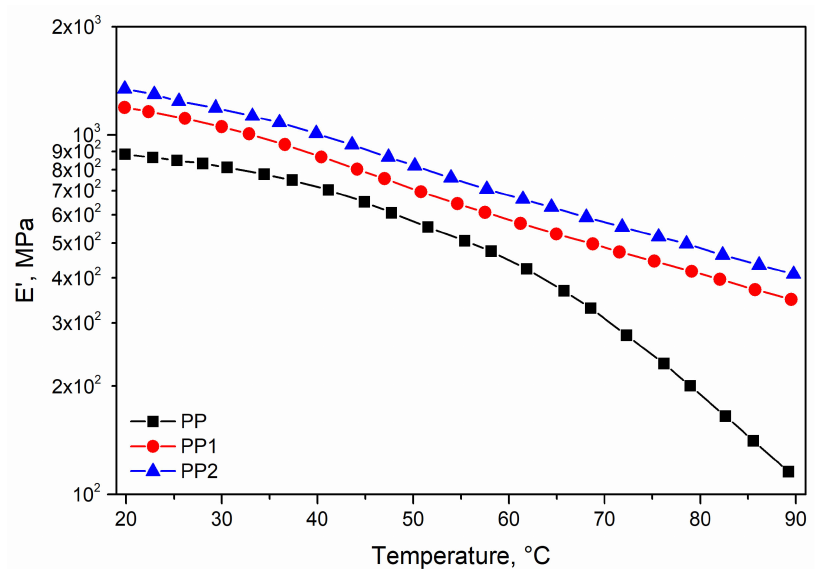
Figure 5. Storage modulus (E (cid:48) ) of polypropylene and polypropylene